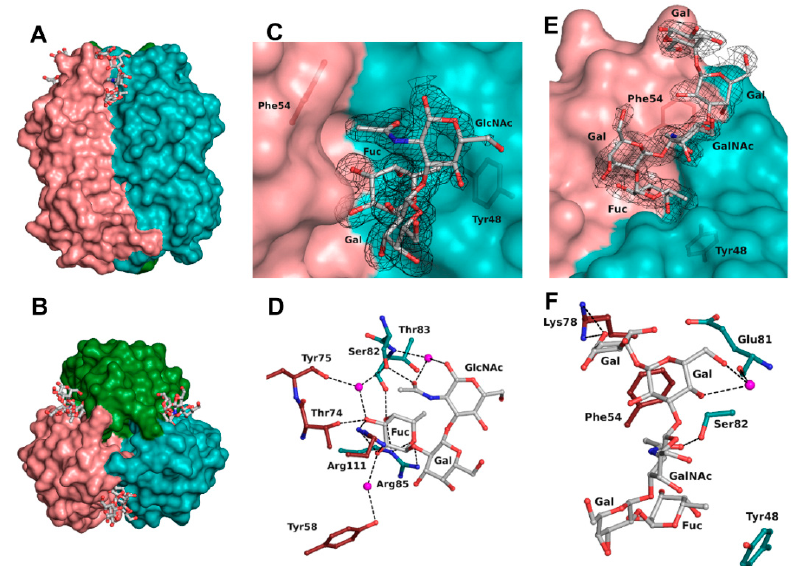
Figure 3. BC2L-CN2 binding site. Surface representation of the trimer of BC2L-CN2 in complex with Globo H, view from the side ( A ) and from the top ( B ). Surface representation of the binding interface between protomers B and C with the electron density displayed around H-type 1 ( C ) and Globo H ( E ) antigens at 1 σ (0.43 and 0.37 eA 3 , respectively. Zoom on the interactions of BC2L-CN2 with H-type 1 ( D ) and Globo H ( F ) antigens. Protein residues are colored by protomer chain. Waters are represented as spheres.